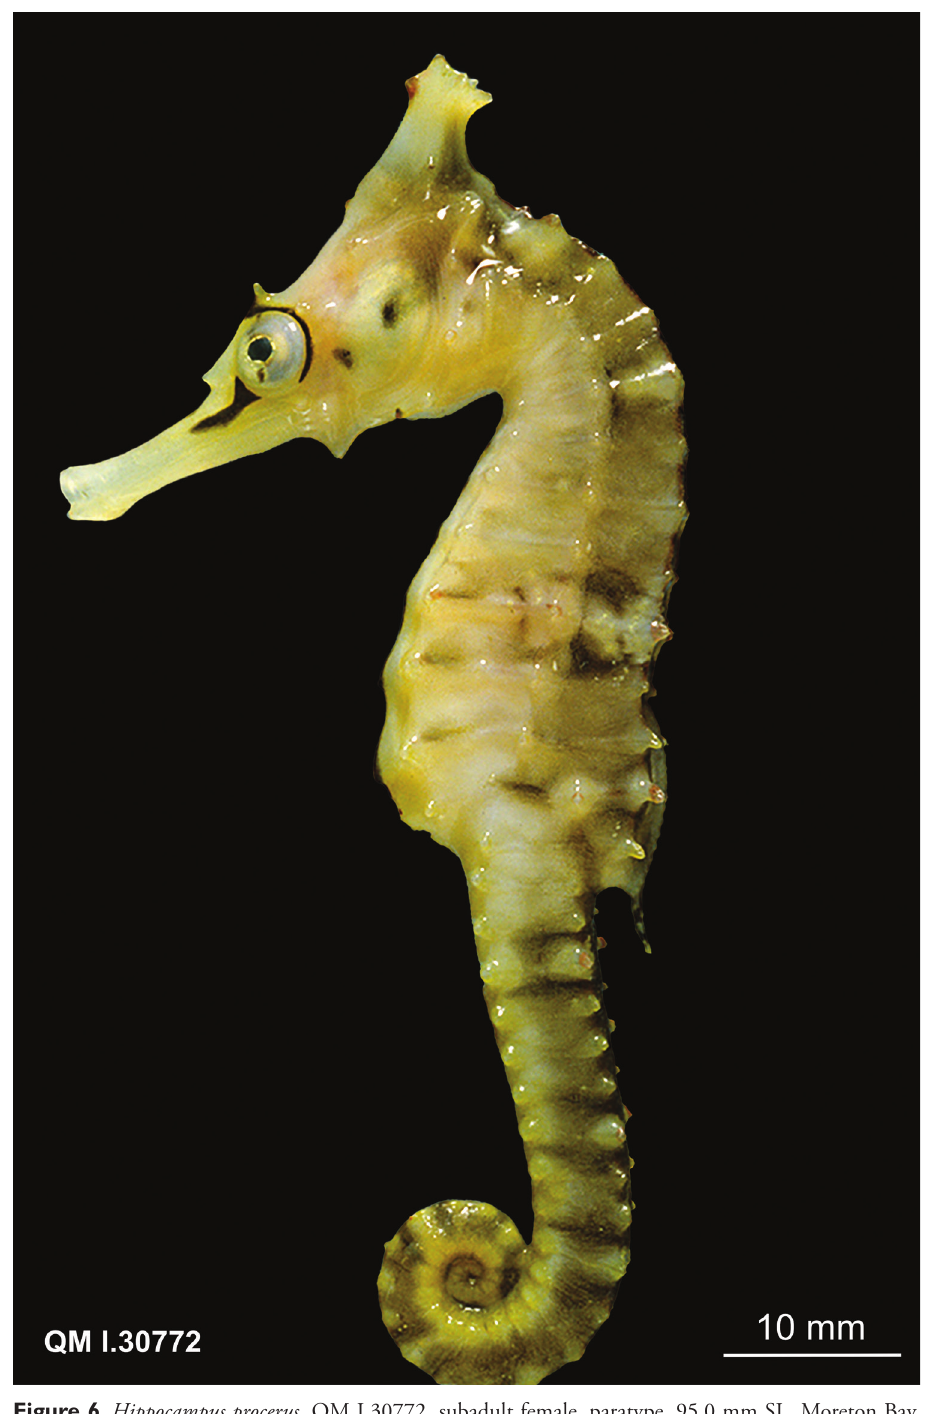
Figure 6. Hippocampus procerus , QM I.30772, subadult female, paratype, 95.0 mm SL, Moreton Bay, Queensland, Australia (photograph Jeff